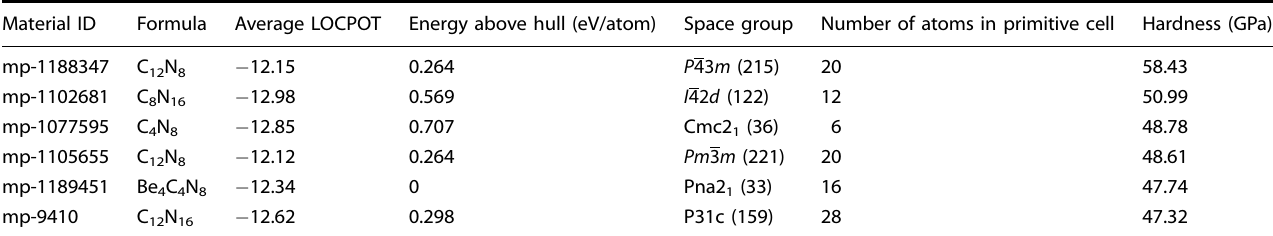
Table 1. Structures identi fi ed by BLOX recommendation with corresponding ultrahigh